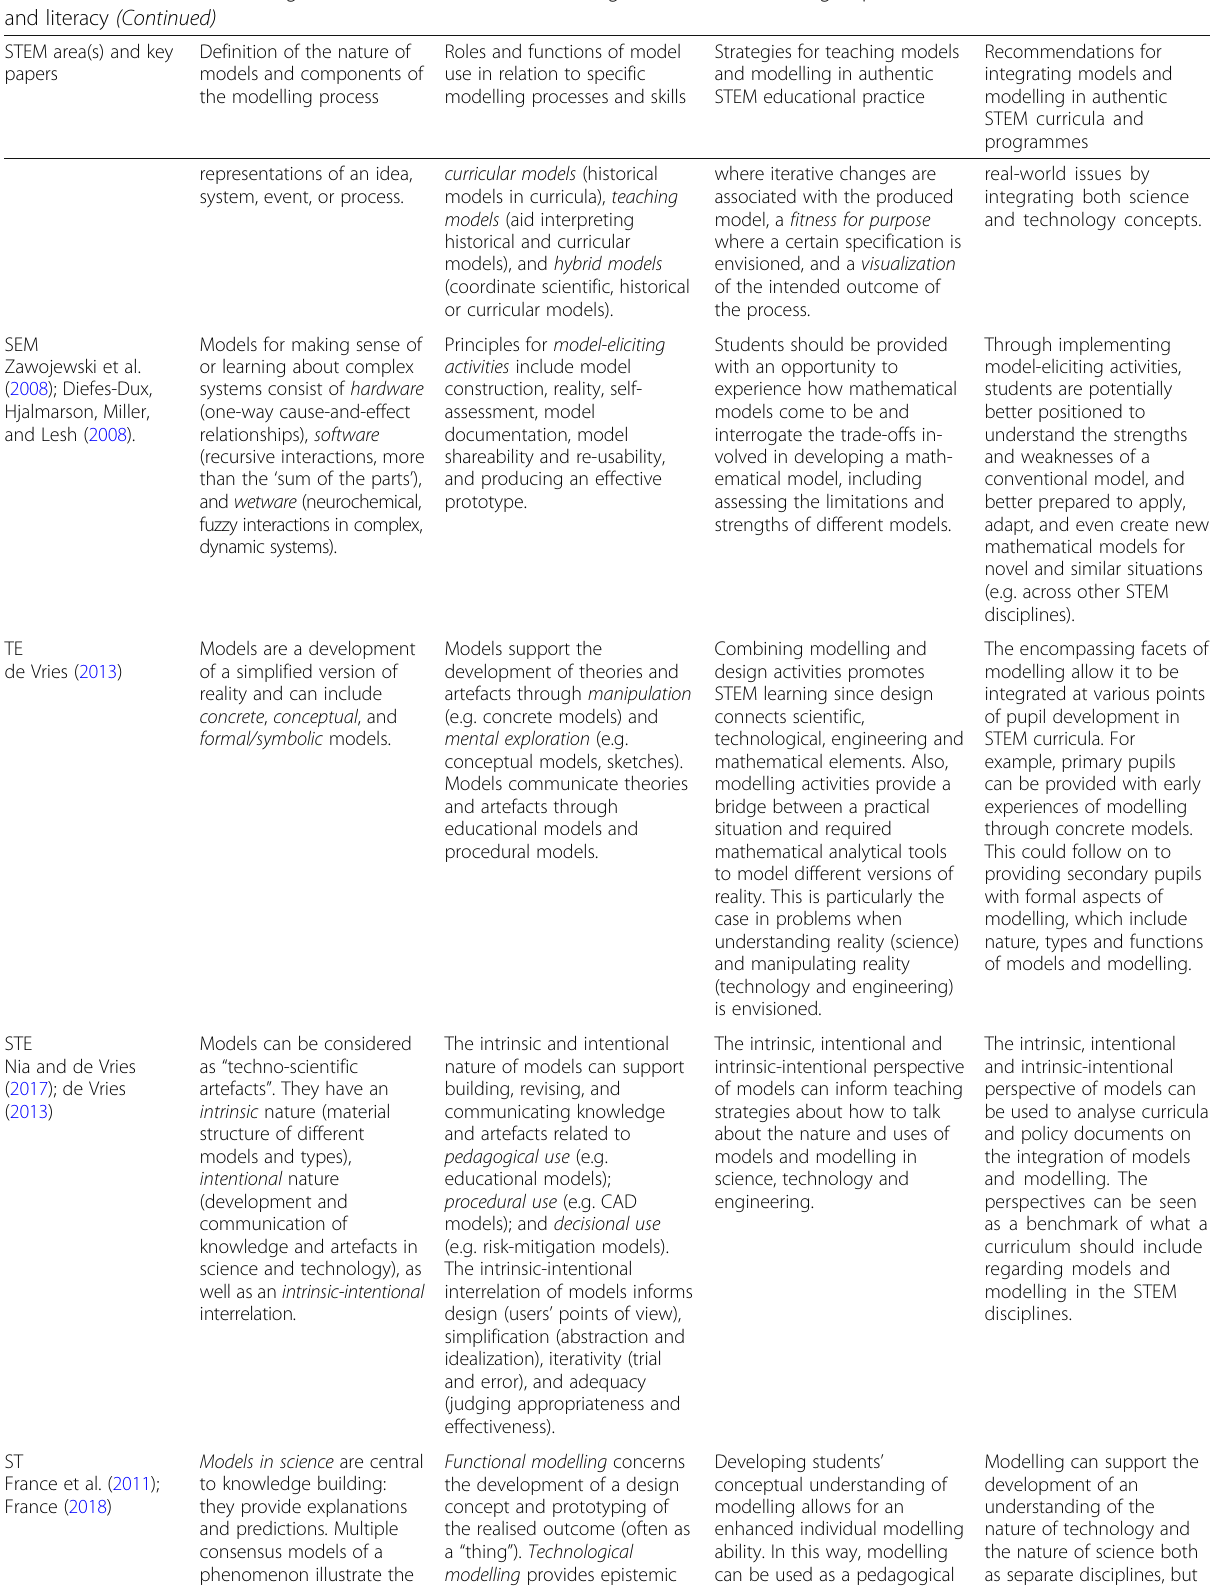
Table 1 Roles, functions, strategies and recommendations for using models and modelling in pursuit of authentic STEM education and literacy